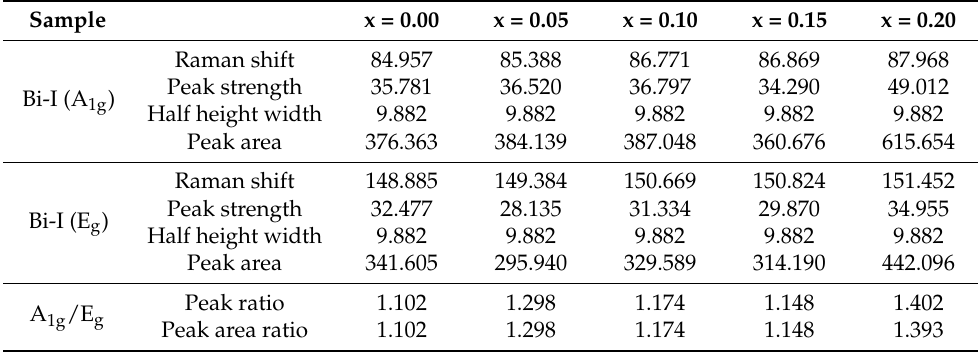
Figure 5. Raman patterns of as-prepared BiOBr X I 1 − X photocatalysts. Table 2. Raman fitting of BiOBr X I 1 − X